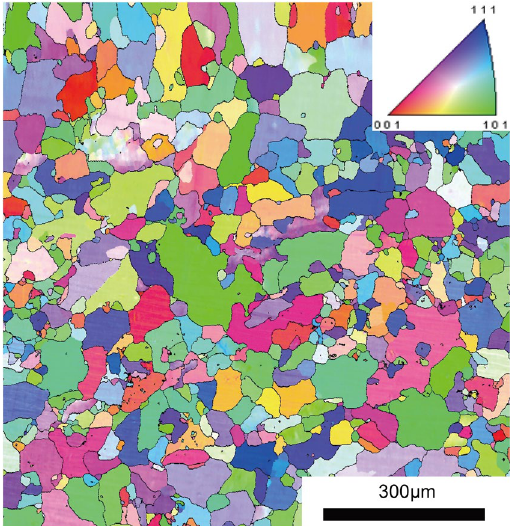
Figure 1. EBSD determined inverse pole figure map for solution treated AA5083 (450 °C/1 hour). The average grain size in the recrystallised microstructure is 63.5 ( ± 22.3) µ